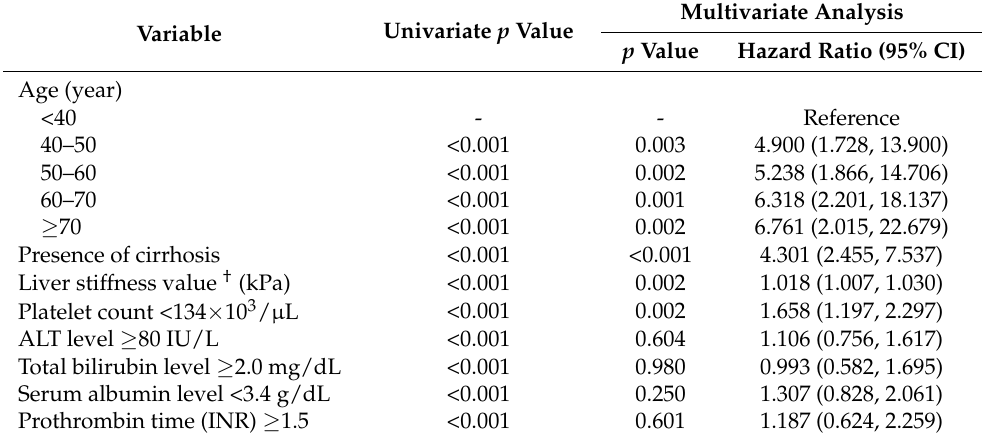
Table 2. Multivariate Cox regression analysis for development of hepatocellular